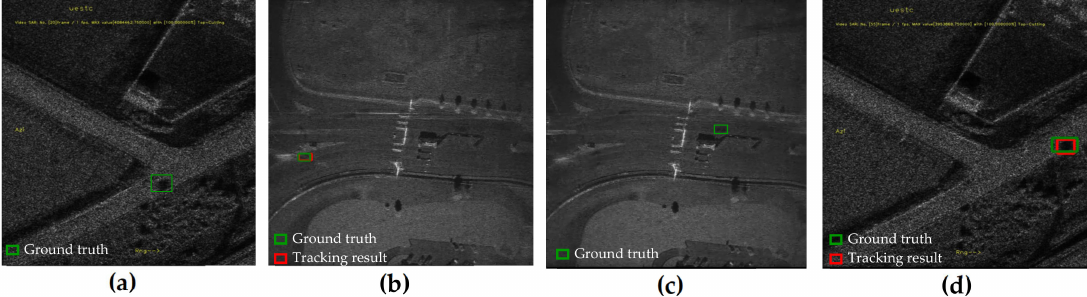
Figure 25. The experimental results of cross-validation: ( a ) simulated Video-SAR data for training; ( b ) real Video-SAR data for testing; ( c ) real Video-SAR data for training; ( d ) simulated Video-SAR data for testing.